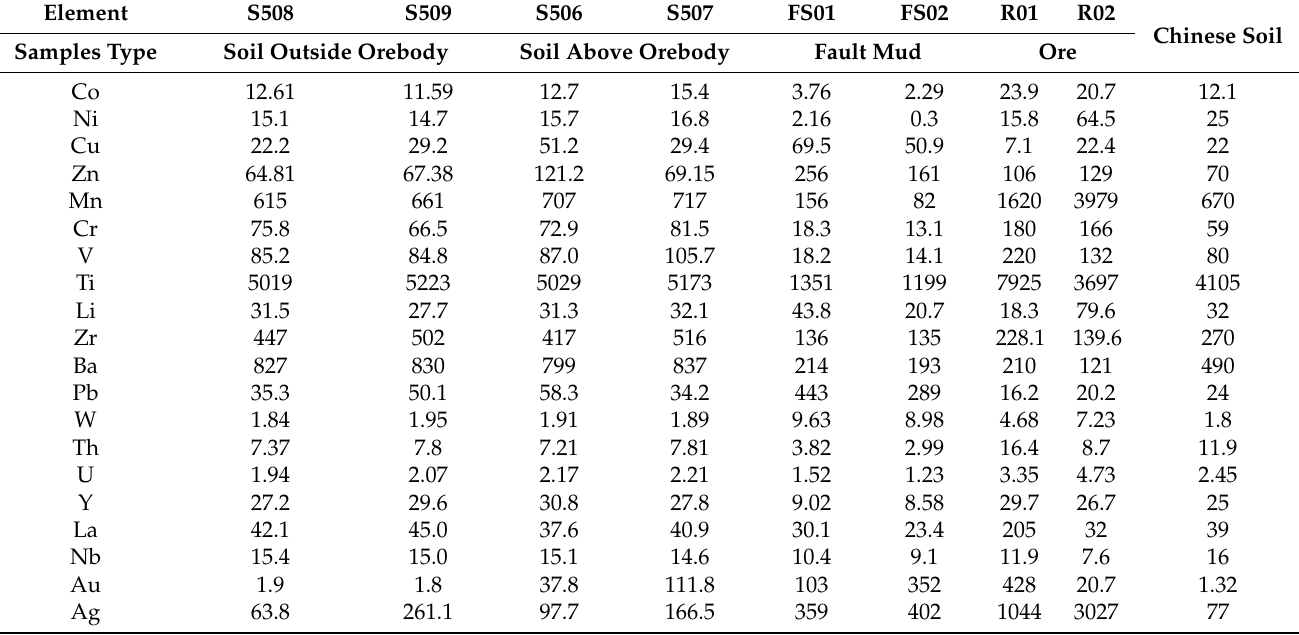
Table 2. Trace element in surface soils, fault muds, and